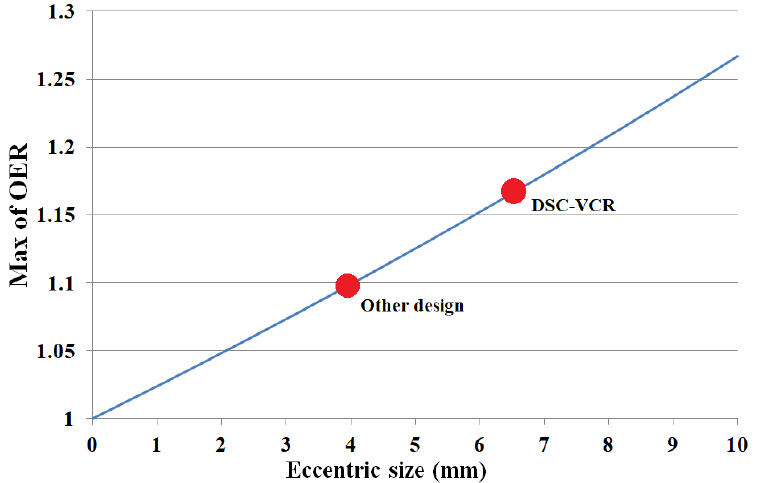
Figure 3. Variation of the overexpansion ratio (OER) with different eccentric sizes.